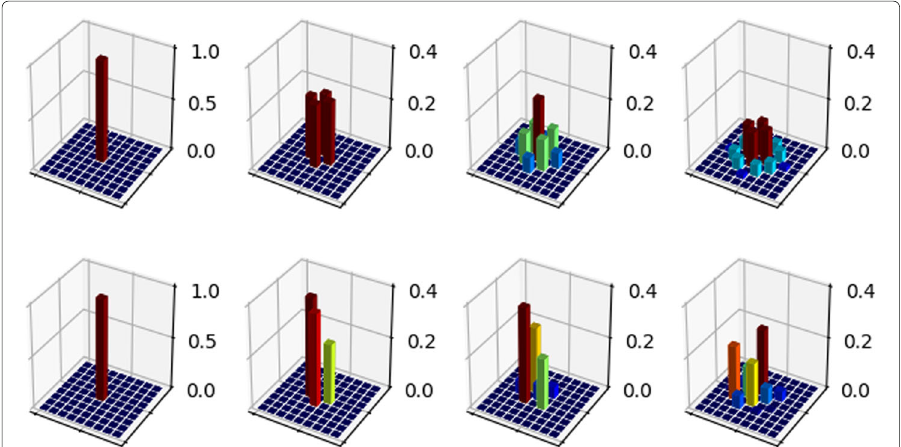
Fig. 1 Classical and Quantum Walk Distributions. The probability distribution of a classical random walk (Top) and a quantum random walk (Bottom) across the nodes of a lattice graph over four steps from left to